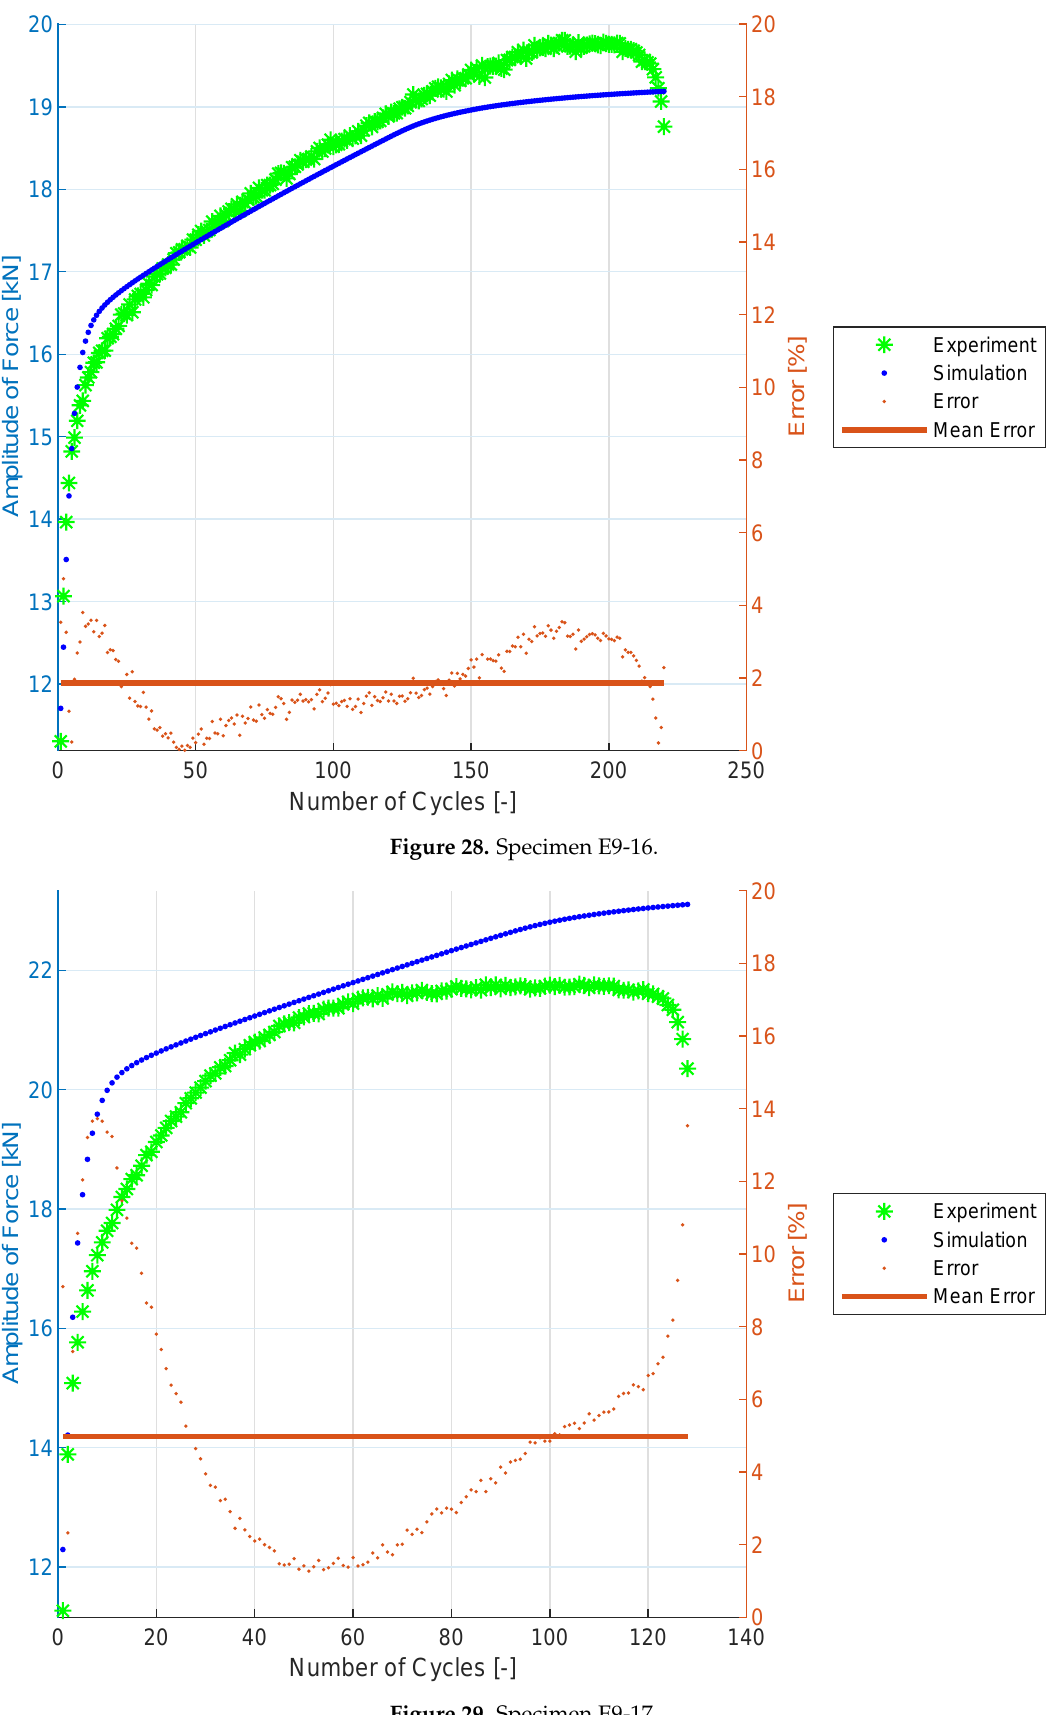
Figure 28. Specimen E9-16.